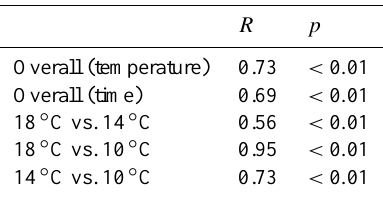
Table 1. Results of a two-way crossed ANOSIM of the effects of temperature and time on biogeochemical parameters (DIC, POC, DOC, NO 3 , PON and DON), including pairwise tests for differ- ences between temperature treatments.